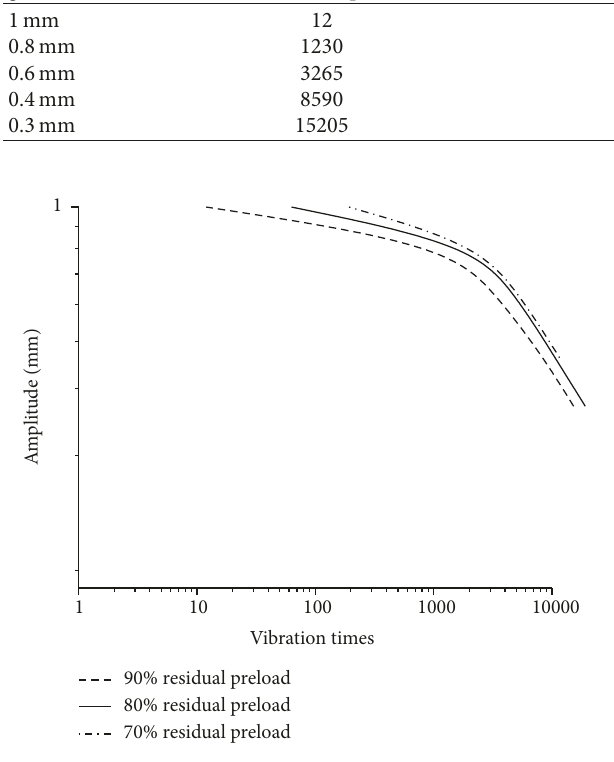
Figure 7: Vibration loosening D - N curve in the logarithmic co- ordinate system.